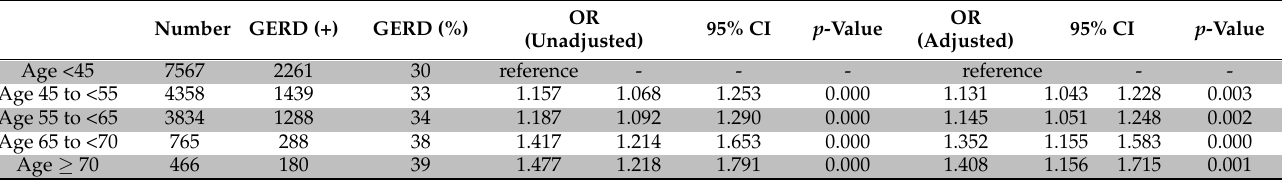
Table 2. Different ages and their risk of GERD.